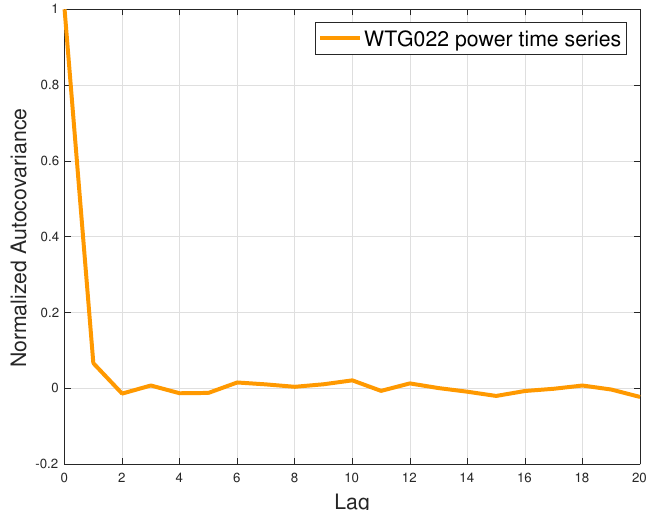
Figure 6. The normalized autocovariance of WTG022 power output (D bef dataset) with maximum lag of 20. The wind direction roses, measured at WTG022, during D bef and D aft are reported in Figure 7 and it arises that the distributions are similar before and after the upgrade of the WTG022. Therefore, it can be argued that, as far as can be analyzed from the data available, the model formulation and use are not remarkably biased by climatology effects. This is supported also by the fact that the ratio between the average nacelle wind speeds at WTG02 during D bef and D aft is 0.96. The SCADA collected data have ten minutes of sampling